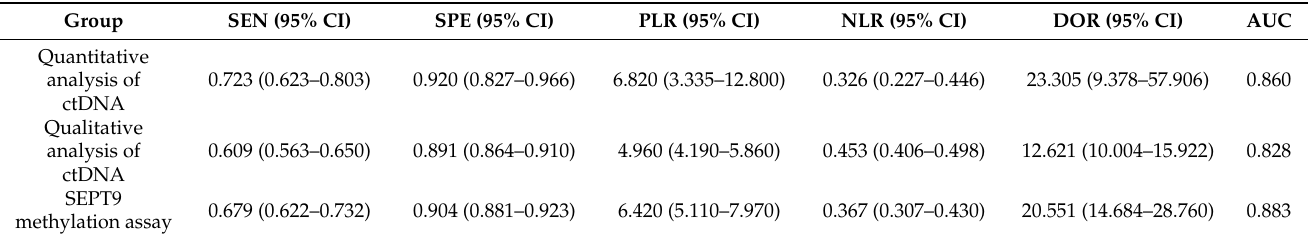
Table 1. Summary of diagnostic accuracy of ctDNA assay for CRC in multiple subgroups.